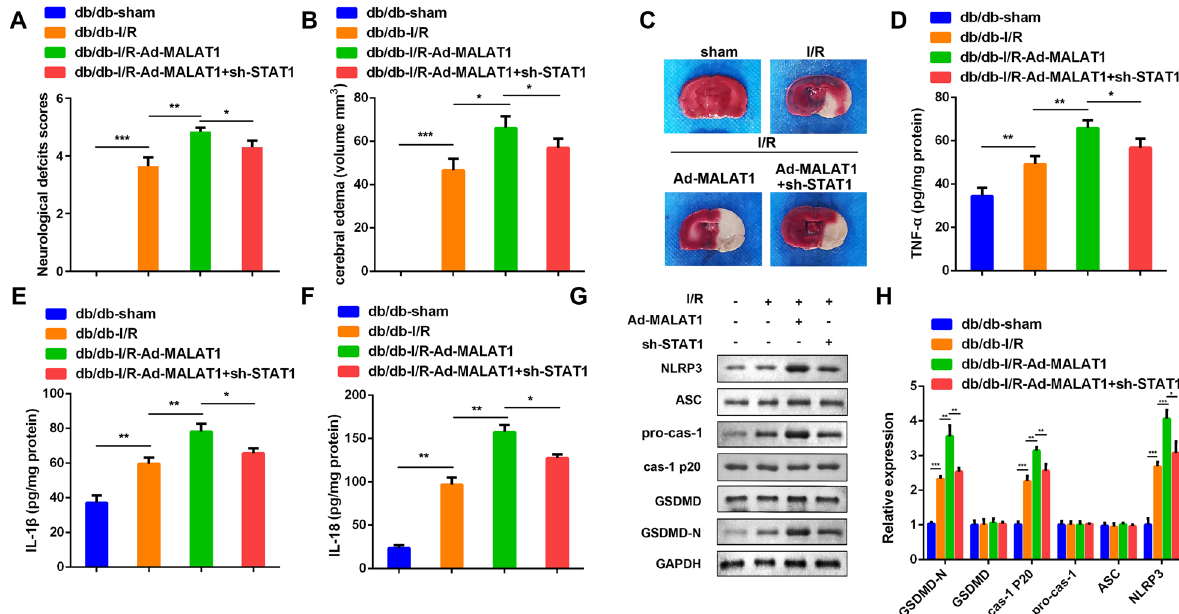
Fig. 7 Knockdown of STAT1 reversed the effect of MALAT1 on cerebral injury and pyroptosis of the diabetic I/R mice. A Neurological scores were assessed in vivo. B Encephaledema volume of the brain slices were calculated according to the formula: V encephaledema (mm 3 ); A1 and A2: front and back encephaledema area of the slides (mm 2 ); t: thickness of the slides (mm). C The brain slices were stained by TTC solution. Pale area represented for encephaledema. The concentrations of TNF-α ( D ), IL-1β ( E ) and IL-18 ( F ) in the brain tissues were measured by ELISA kit. G , H The protein expression levels of GSDMD-N, GSDMD, caspase-1 p20, pro-caspase-1, ASC and NLRP3 in the mice underwent indicated treatment were detected by RT-qPCR 72 h after I/R modeling. (n